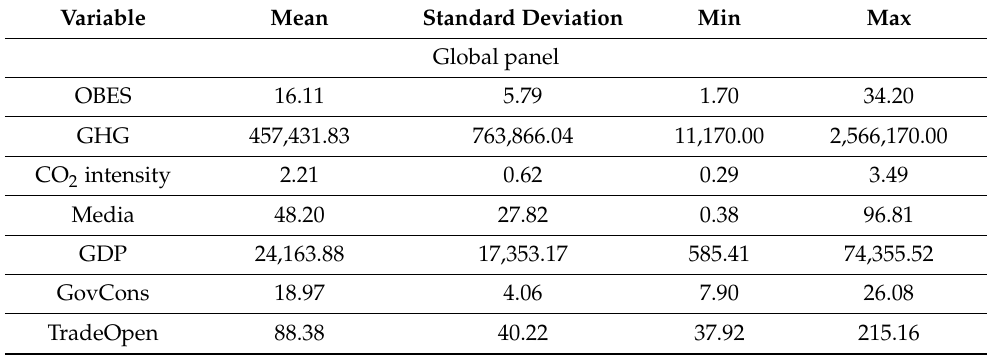
Table 3. Descriptive statistics.